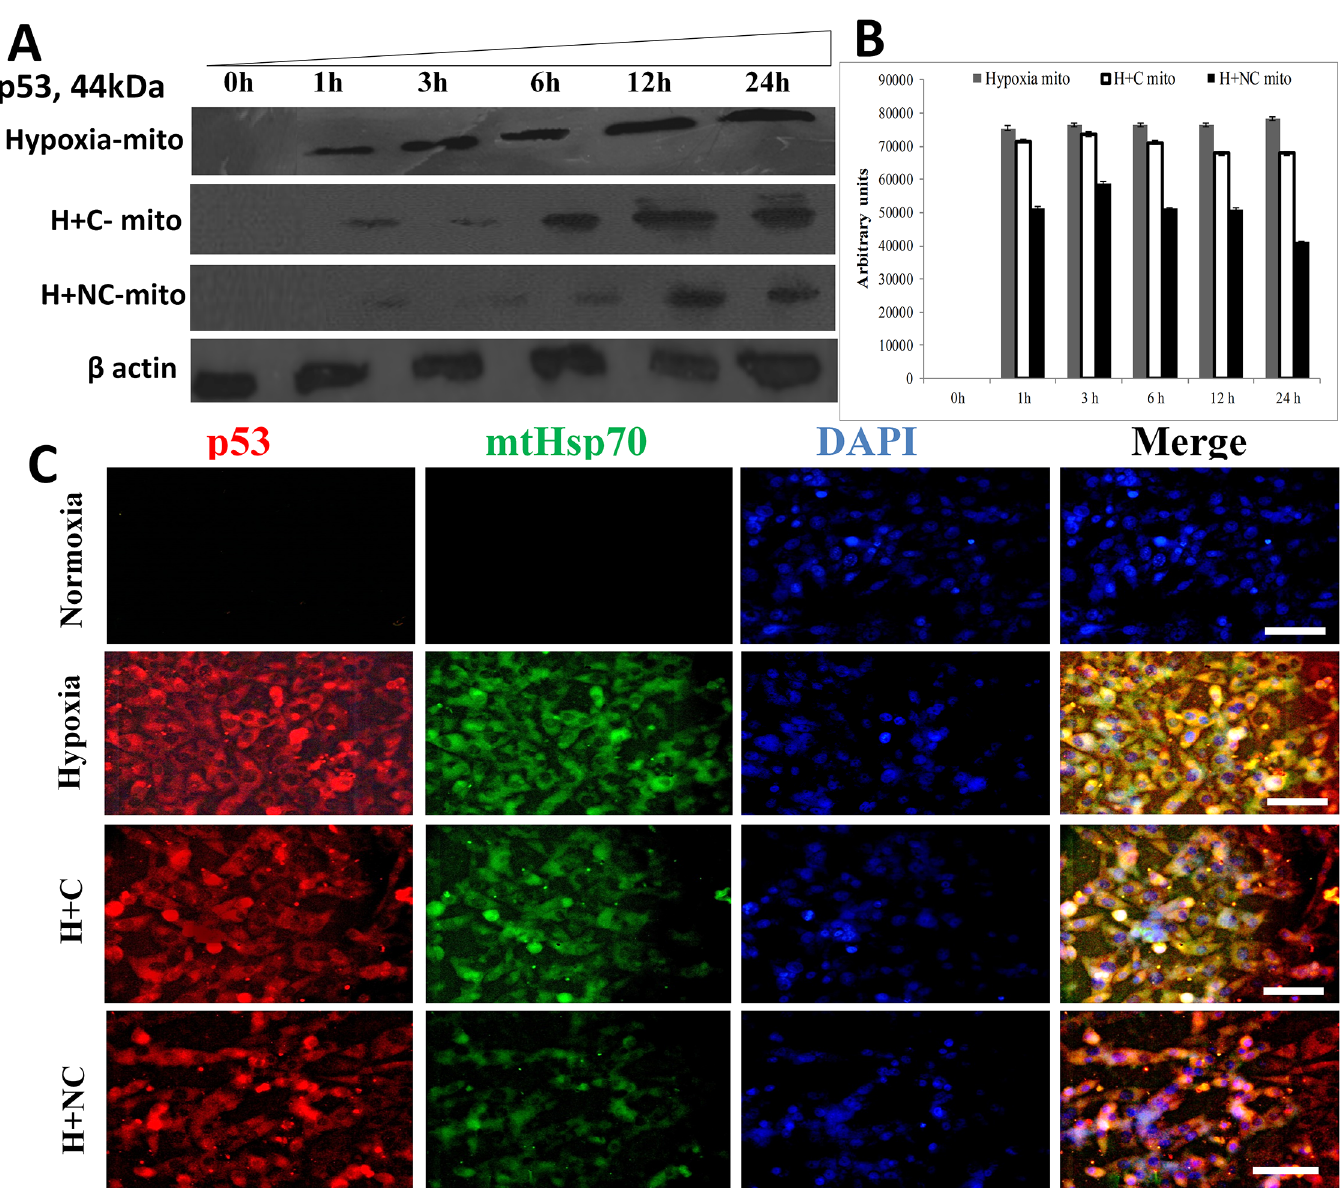
Fig 7. Nanocurcumin prevents hypoxia induced mitochondrial translocation of p53 in HVCM cells: Translocation of p53 in mitochondria (mito) in HVCM cells was time-dependent and initiated within1 h of hypoxia. Nanocurcumin prevented p53 translocation to mitochondria in HVCM cells under hypoxia better than curcumin (A, B). Also, enhancement in levels of p53 (Red) and mtHsp70 (Green) was observed after hypoxia insult in HVCM cells after 24 h (C). Nanocurcumin treatment down-regulated p53 and mtHsp70 levels better than curcumin treated cells under hypoxia. Bar represents 10 μ